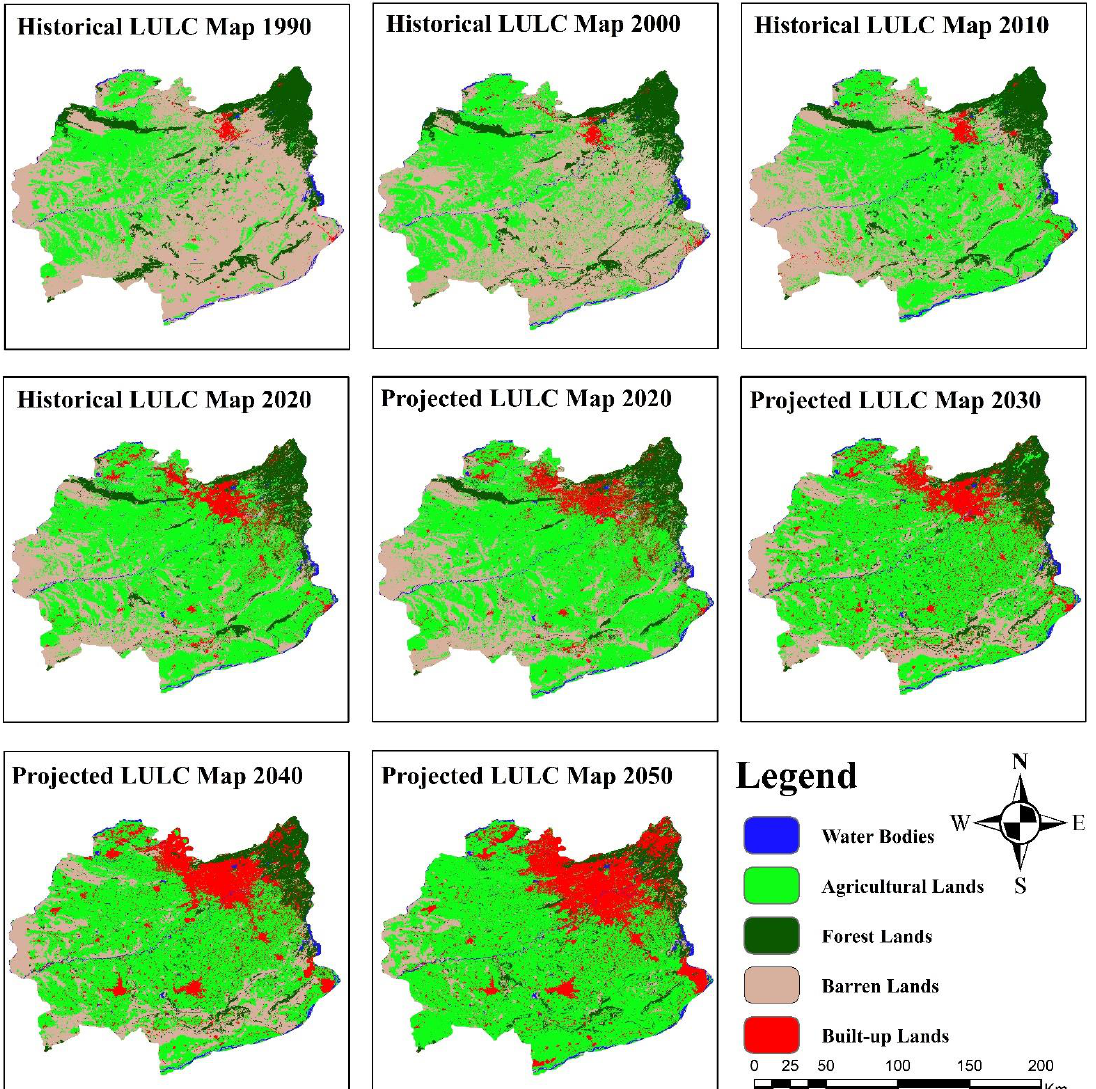
Figure 4. Spatio-temporal variation of LU/LCs, historical and projected.